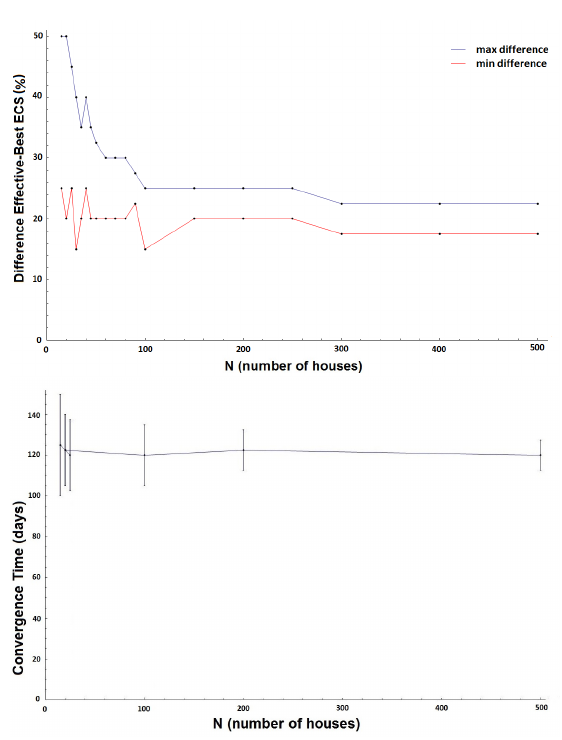
Figure 5. The upper plot shows the maximum (blue) and minimum (red) difference in percentage (converging to 20% ) between best and effective total load varying the number of houses from 15 to 500 . The plot below refers to necessary time to the district to reach a stable state ( 3 − 6 months) and a stable difference between the two loads, compared to the number of houses from 15 to 500